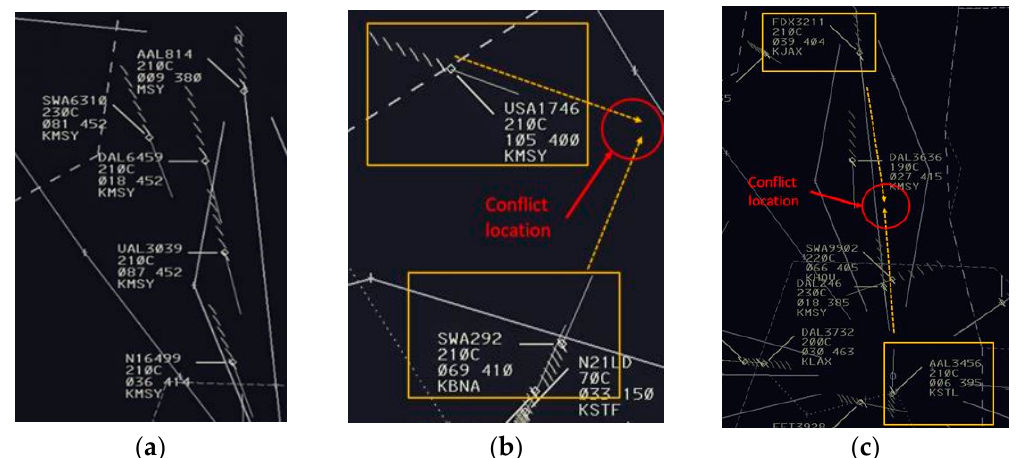
Figure 2. Example scenarios: ( a ) Layout of aircraft during an experiment using one of the scenarios; ( b ) Example of aircraft conflicts highlighted in red and yellow (left side shows the aircraft layout at a certain point in time, and the right side shows the future conflict locations.